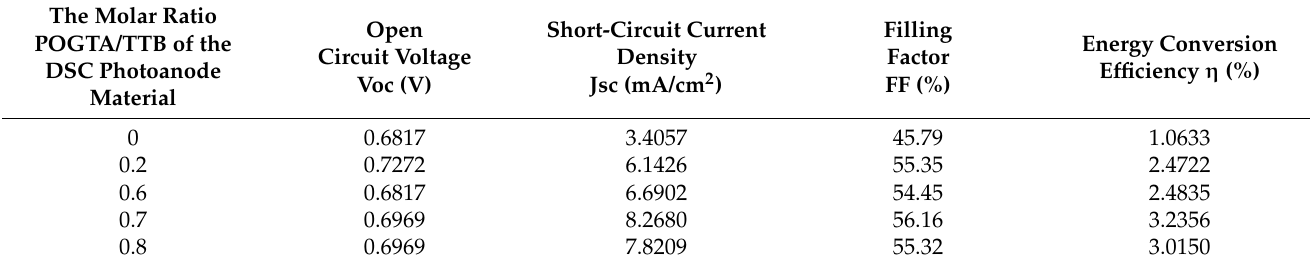
Figure 8. I–V test curves of seven-layer thin film anode DSC when the molar ratio POGTA/TTB = 0, 0.2, 0.3, 0.6, 0.7, 0.8. Table 1. The performance parameters of the photoanode assembly DSC of the seven-layer TiO 2 film prepared under different conditions of POGTA/TTB.